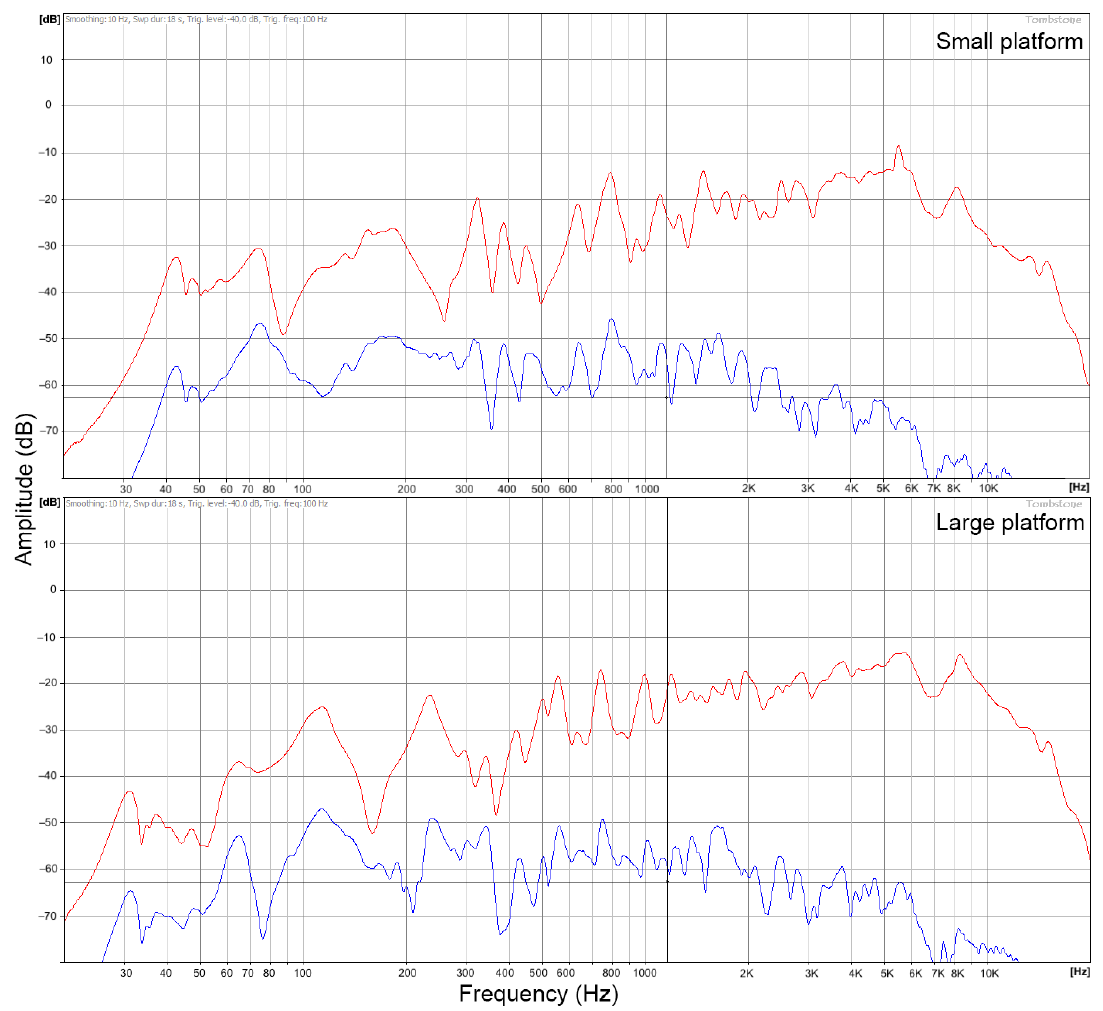
Figure 6. Results from accelerometer measurements on one of the small ( top ) versus large ( bottom ) platforms in Sound Forest when no one is standing on the platforms. The red curve corresponds to audio captured using a microphone placed on the floor. The blue curve corresponds to the signal recorded by the